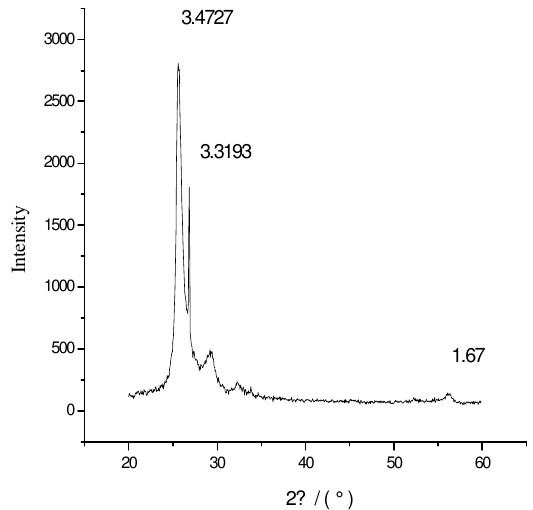
Figure 2. The X-ray diffraction spectrum of expandable